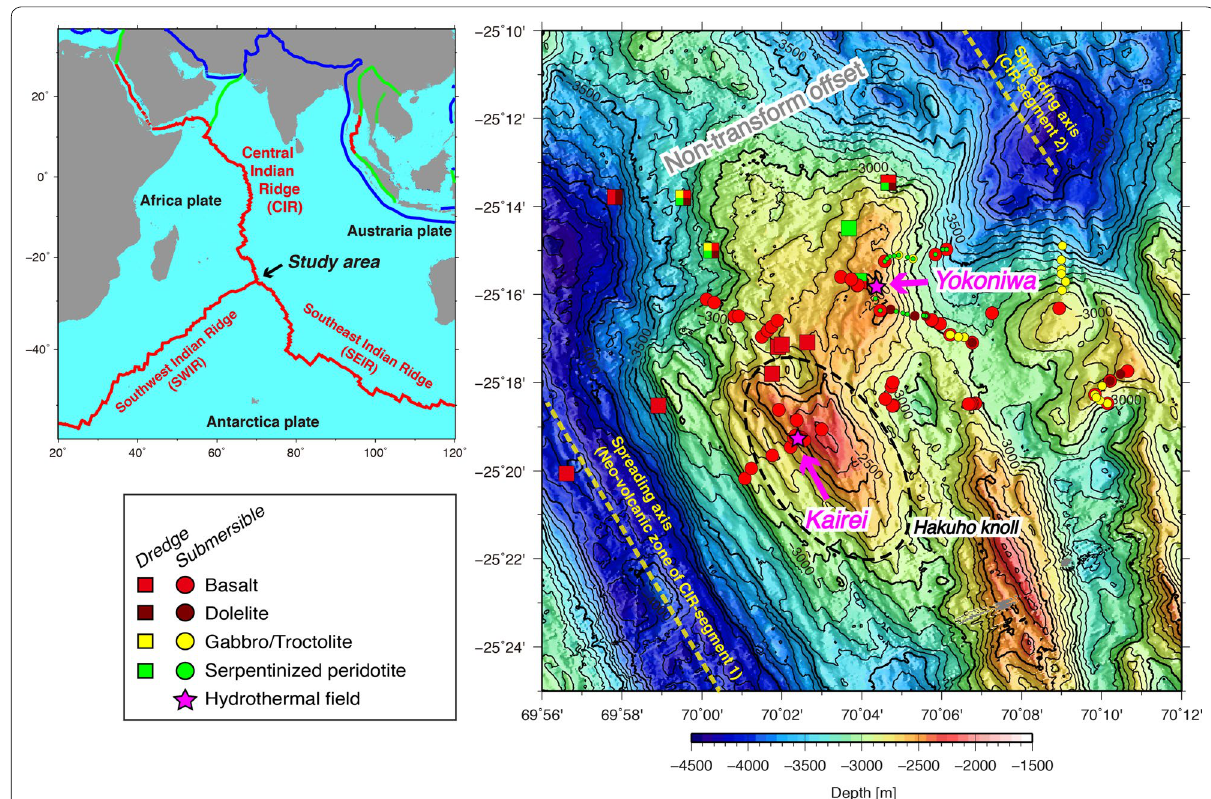
Fig. 1 Geological background and seafloor bathymetry of the study area. Rock samples collected by dredge (squares) and submersible (circles) are shown as basalt (red), dolerite (brown), gabbro (yellow), and serpentinized peridotite (green). Locations of the Kairei and Yokoniwa hydrothermal fields are shown as purple